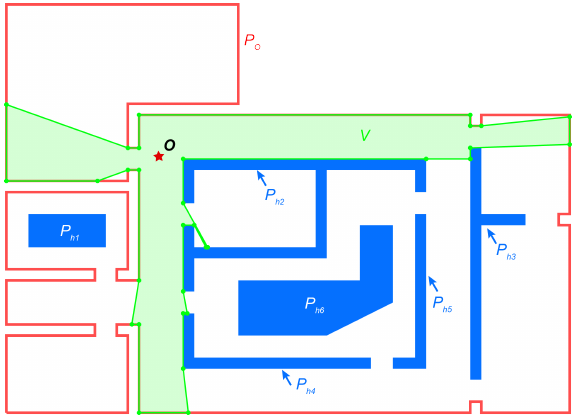
Figure 1: Example of visibility polygon of a complex room. The outer bound polygon P o is outlined in red. Interior obstruction polygons P h j , j = 1 ... 6 are represented as blue areas. The inte- rior of these polygons is not visible. The view point O is depicted as the red star. The visibility polygon V from this location O is represented as the green area.